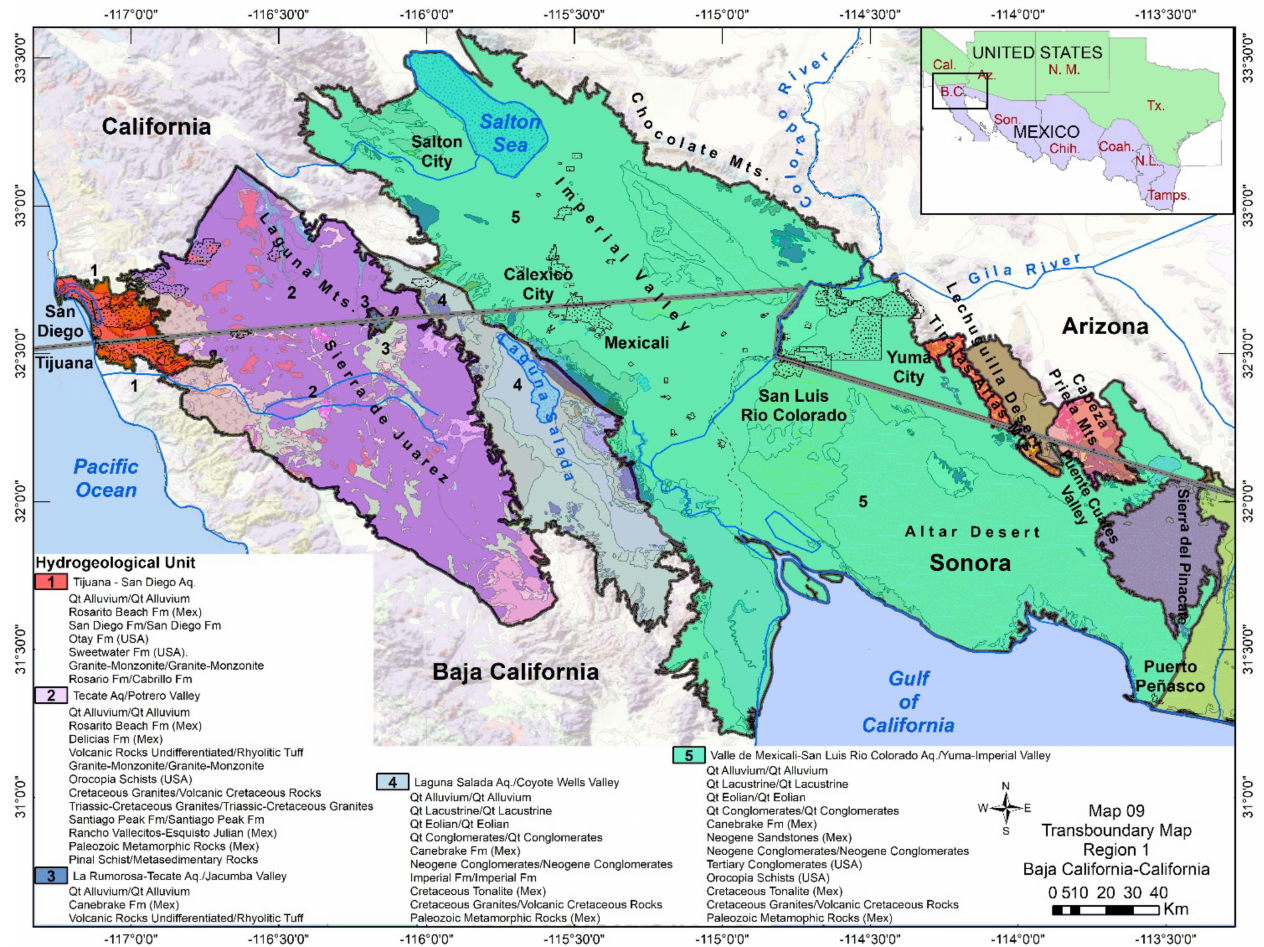
Figure 9. Transboundary map, Baja